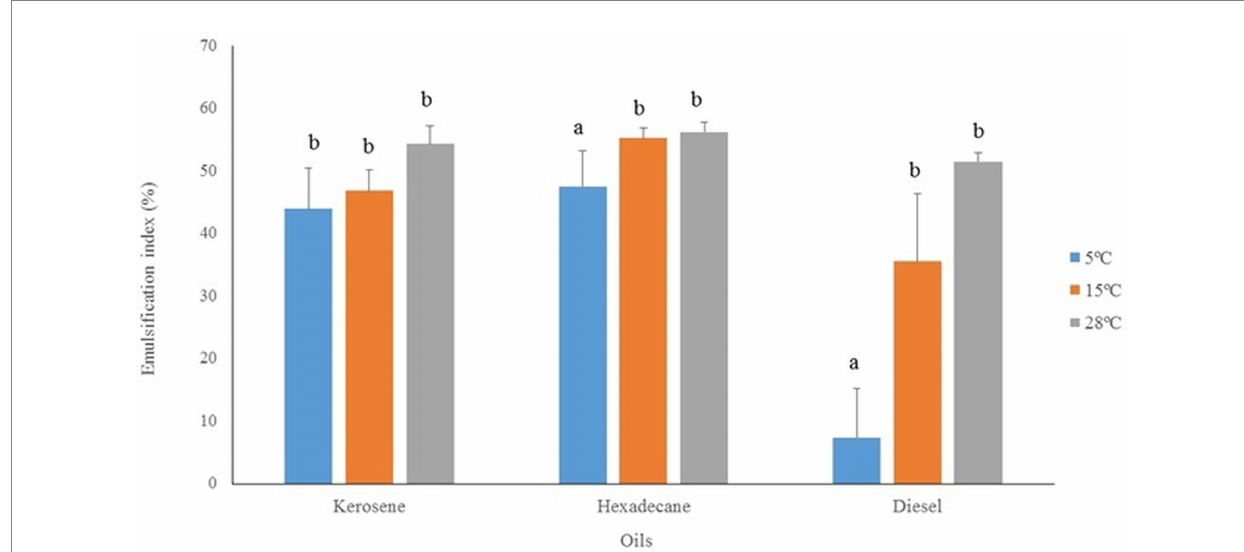
FIGURE 5 Emulsifying indexes (E24) of P. antarcticus IPAC21 with different oils (kerosene, n-hexadecane, diesel) after IPAC growth in TSB at 5 ° C, 15 ° C, and 28 ° C. Different letters indicate statistically significant differences (Tukey, p <